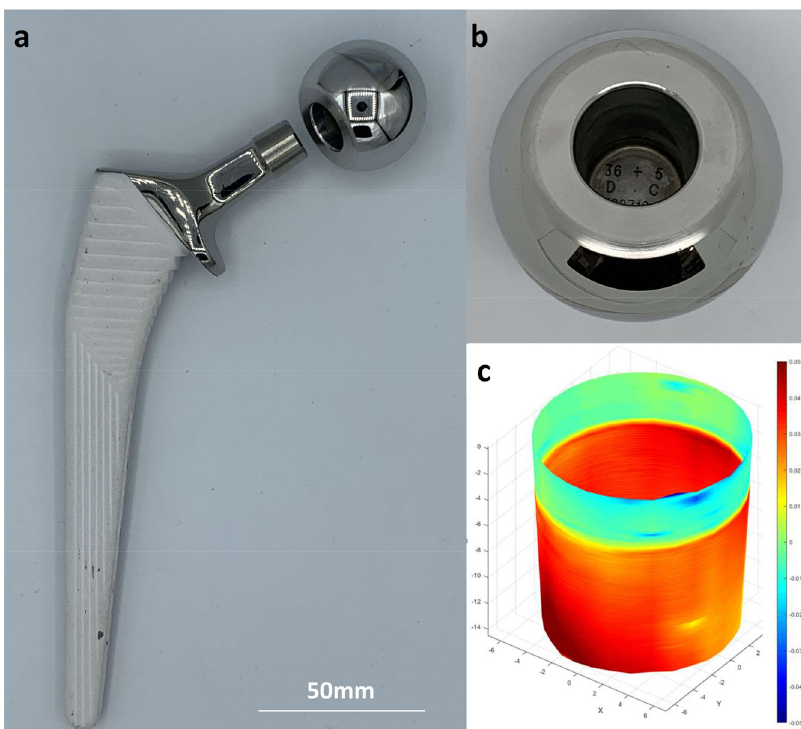
Fig. 2 The structure of total hip replacements (THRs). a In total hip arthroplasty, the femoral neck is sectioned and a femoral stem (titanium, uncemented for the patients in this study) placed down the femoral canal. The femoral head is press fi t on to the stem, creating the taper junction. b Metal debris can be generated from the taper junction, the great majority of which is released from the CoCr head. For the explanted THRs in this study, material loss from the bearing and tapers was quanti fi ed using a coordinate measuring machine. c A taper wear map is shown, with red areas indicating areas of material loss greater than 50 microns in